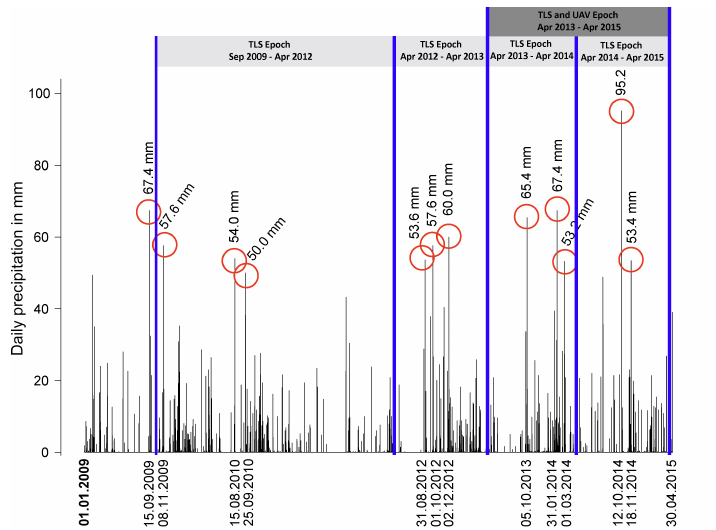
Figure 11. Daily precipitation at the Vecchia Aurelia metro station in the northeast of Piombino (UTM coordinates: 631512.00E, 4764190.00N) for the period April 2009–April 2015, provided by the Servizio Idrologico Regionale (www.sir.toscana.it).